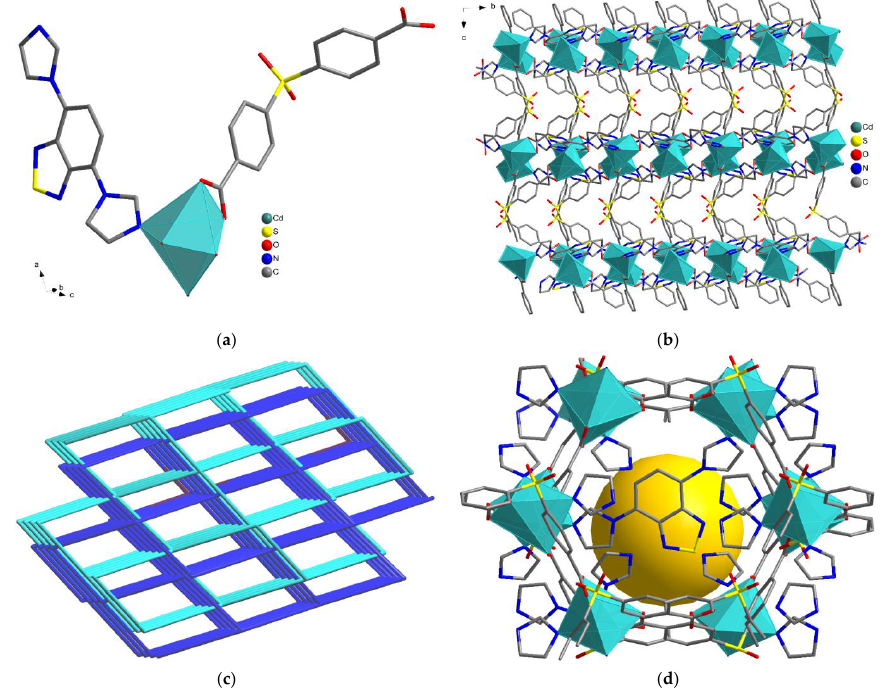
Figure 1. Crystal structure of MOF 1 : ( a ) The content of the asymmetric unit showing the Cd 2+ coor- dination polyhedron. H-atoms and disordered solvent molecules are omitted; ( b ) View of the 3D framework along the a axis; ( c ) Topological representation with interpenetration; ( d ) Representation of a single cavity in the structure; the yellow sphere represents the solvent-accessible volume. Three out of four im 2 btd ligands were omitted for clarity.